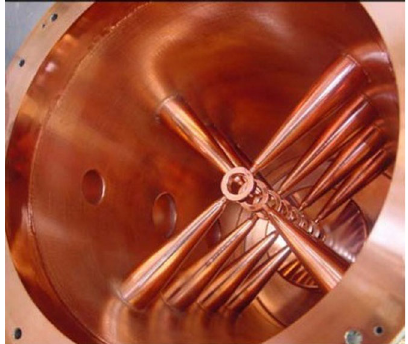
FIG. 18. A copper plated CH-DTL structure.